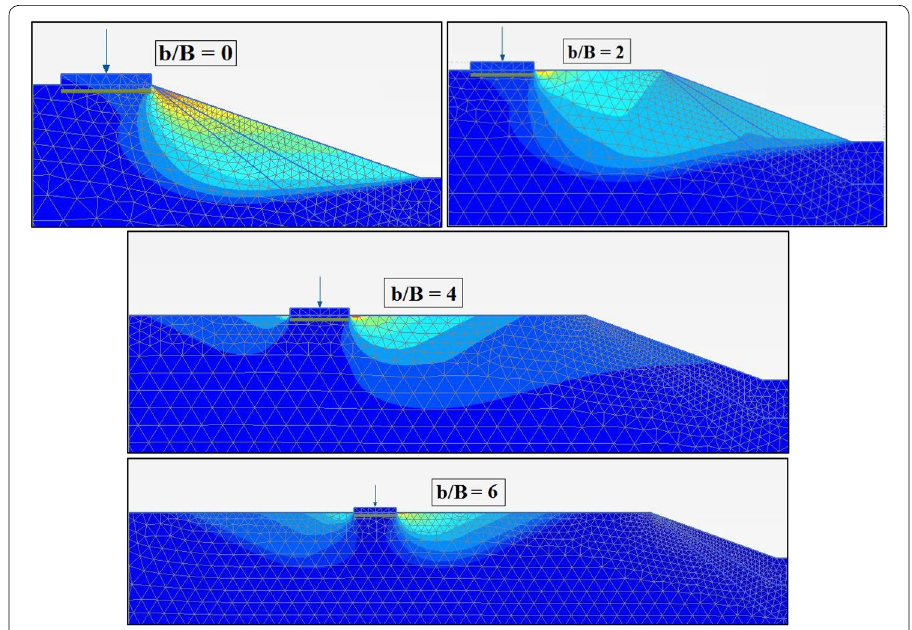
Fig. 14 Typical formation of passive zones beneath the strip footing for various setback ratios ( b/B